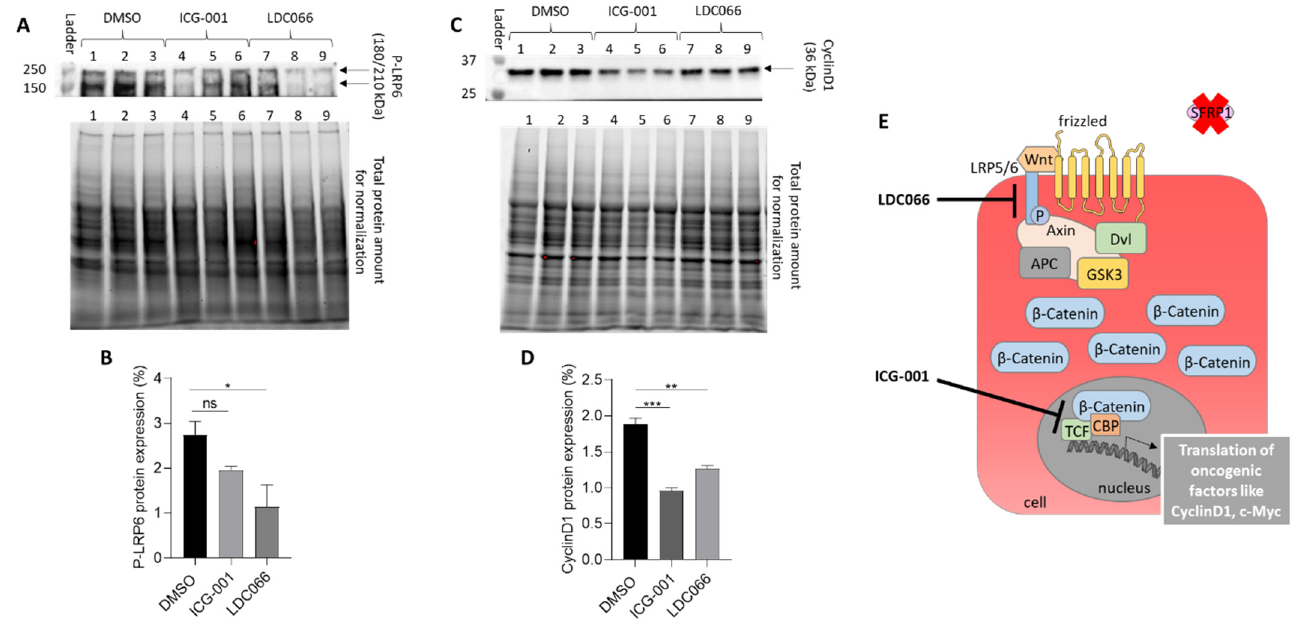
Figure 9. Secondary pathway assay for a representative and optimized SFRP1 mimetic hit, showing potential regulation of the Wnt/ β -catenin signaling in BT20 breast cancer cells. DMSO (lanes 1, 2, 3) serves as negative diluent control and ICG-001 (lanes 4, 5, 6) as reference drug. ( A , B ) Protein expression of the phosphorylated LRP6 receptor (P-LRP6) shows significant down-regulation in the presence of LDC066 (LDC066 is an optimized analog of an SFRP1 mimetic screening hit, lanes 7, 8, 9), but not by ICG-001. All compounds are added as triplicates (ICG-001 at 20 µM, LDC066 at 10 µM). ( C , D ) Protein expression of the transcription factor cyclin D1 is significantly downregulated by ICG-001 and LDC066 since both substances down-regulate the Wnt signaling cascade at the level of gene transcription, and cyclin D1 is a TCF/CBP-regulated gene. ( E ) Cartoon of active Wnt/ β -catenin signaling cascade. LDC066 seems to down-regulate the active LRP6 receptor (“P-LRP6”) at the cell surface, while the reference drug ICG-001 antagonizes the TCF/ β -catenin/CBP-dependent transcription in the cell nucleus. Consequently, both drugs mediate down-regulation of the oncogenic transcription factor cyclin D1, a key transcription factor in active Wnt signaling. (ns: not significant, *: p < 0.05, **: p < 0.01, ***: p < 0.001).